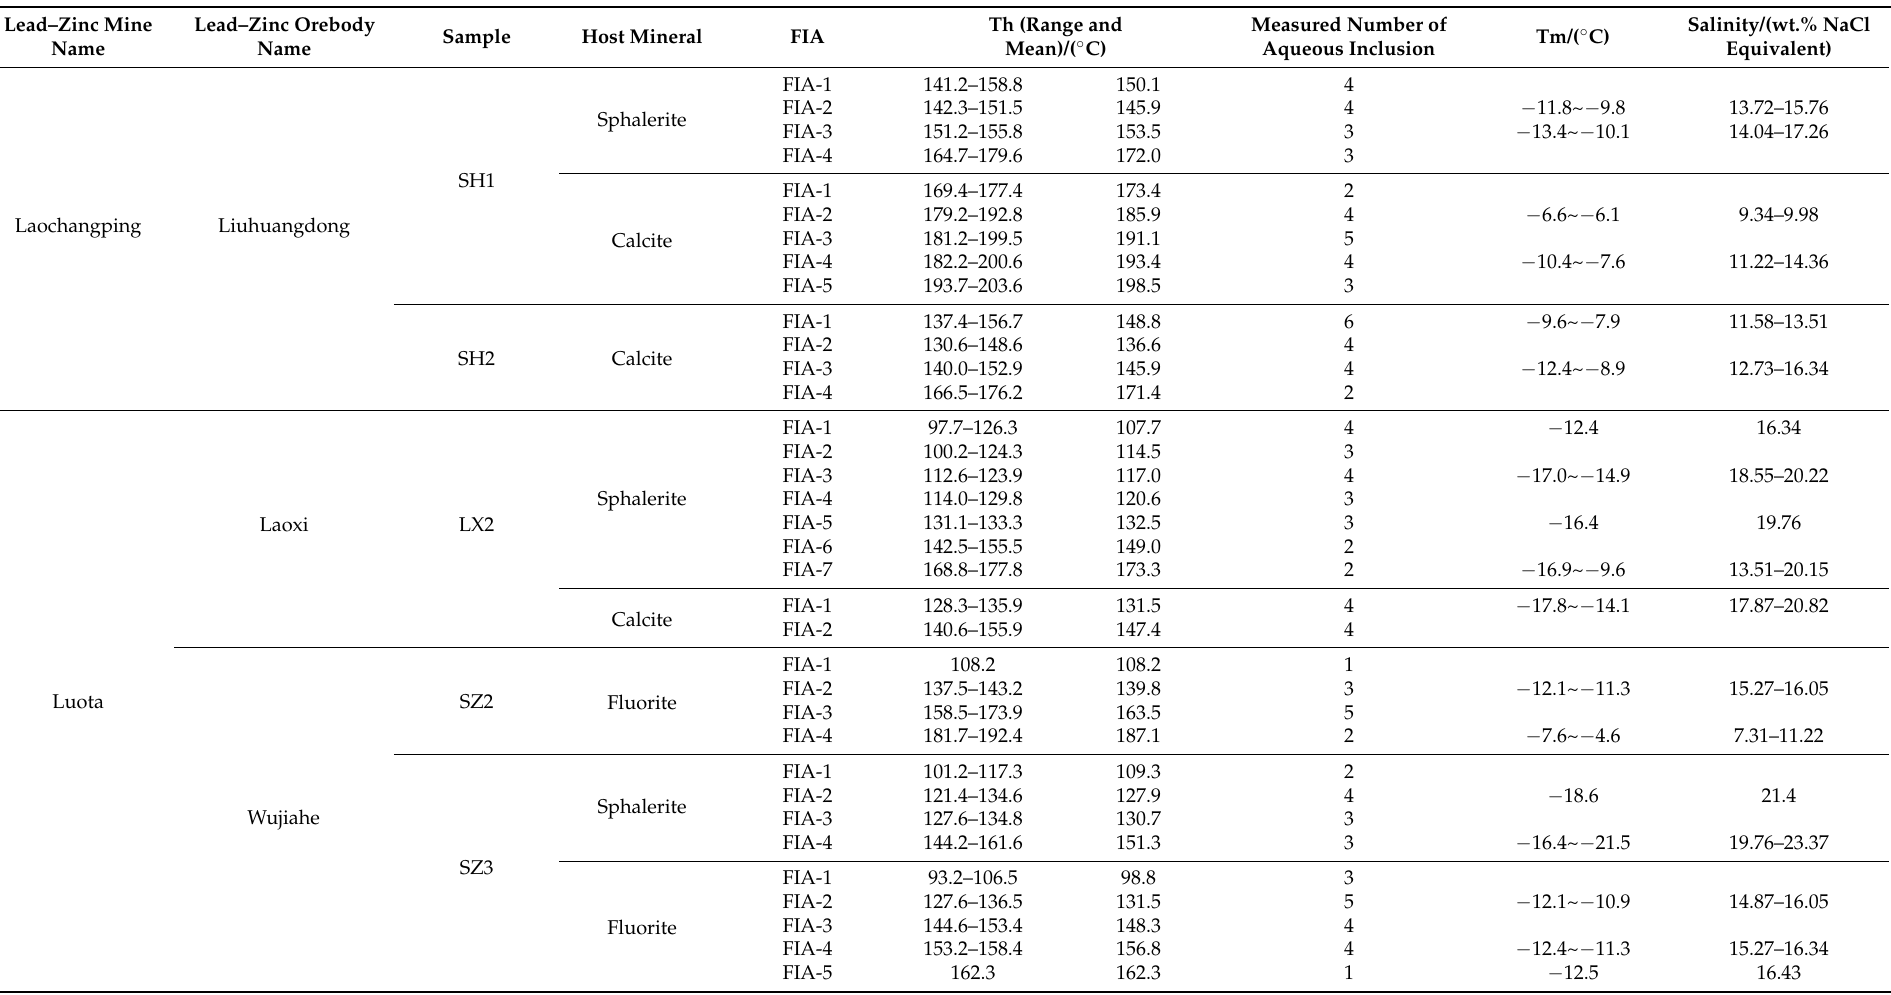
Table 2. Measured homogenization temperatures (Th), final ice-melting temperatures (Tm) and calculated salinity data of the aqueous fluid inclusions in